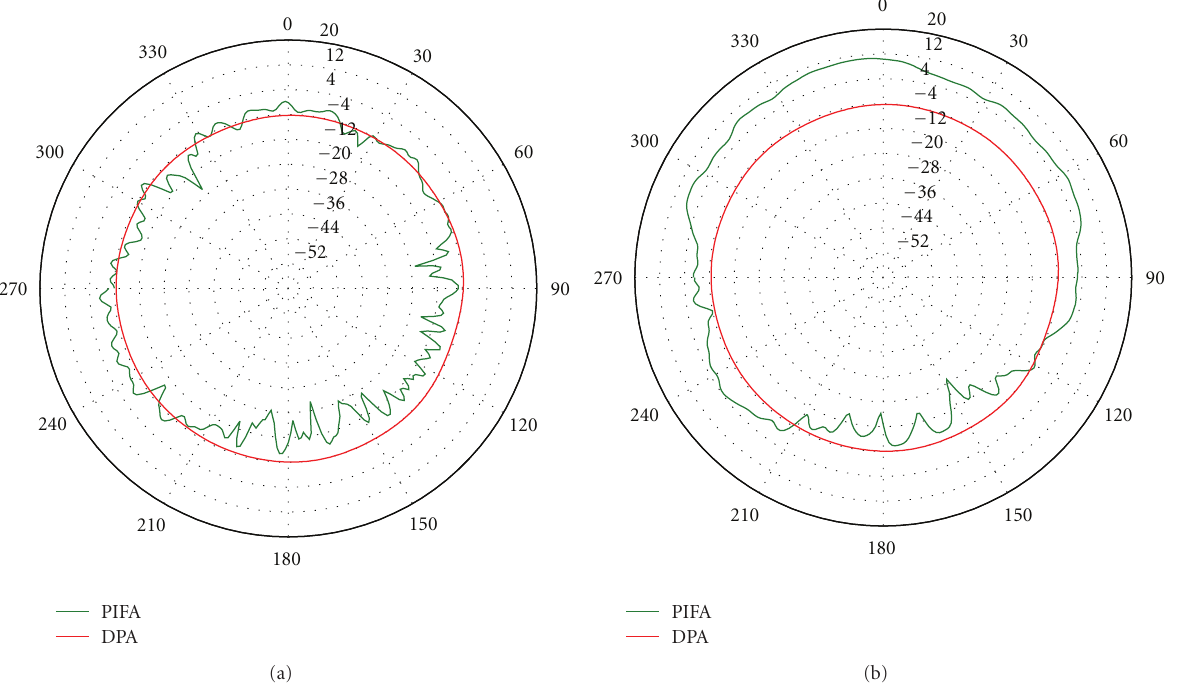
Figure 2: Measured radiation patterns (in dBi) on the azimuth plane ( x - y ) for (a) antenna port 1; (b) antenna port 2.